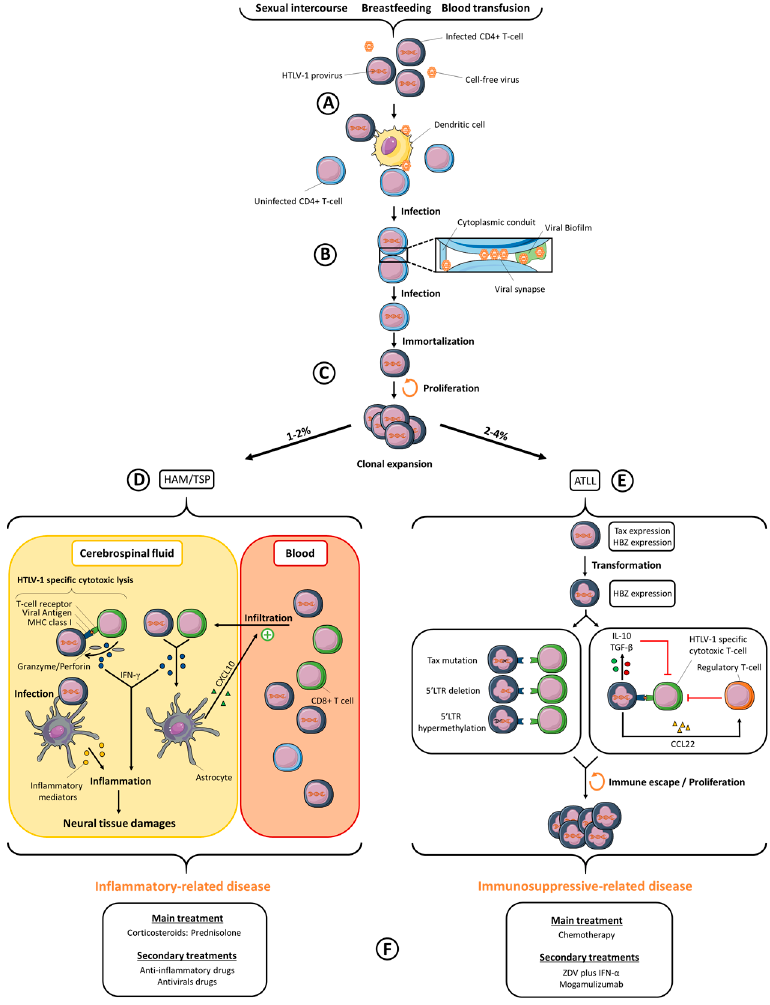
Figure 1. The course of HTLV-1 (Human T-cell Leukemia Virus type-1) infection. ( A ) HTLV-1 transmission through sexual intercourse, breastfeeding or contaminated blood products will allow the dissemination of HTLV-1 infected cells at the vicinity of dendritic cells, which are then able to transmit HTLV-1 viruses to CD4+ T-cells; ( B ) Neo-infection of CD4+ T-cells, which requires a cell-cell contact between an infected and a non-infected T-cell, is achieved through cellular conduits, the viral synapse or the viral biofilm; ( C ) Tax expression in HTLV-1 infected cells will result in consequent cell signaling alterations, such as continuous proliferation and apoptosis inhibition. Immortalized HTLV-1 infected cells will then proliferate through mitotic divisions, also known as clonal expansion; ( D ) TSP/HAM (Tropical Spastic Paraparesis/HTLV-1 Associated Myelopathy) is an inflammatory-related disease, which appears in 1 to 2% of infected individuals. The production of IFN- γ (Interferon- gamma), by HTLV-1 infected cells and HTLV-1 specific cytotoxic cells infiltrated in the cerebrospinal fluid, will lead to neural tissue damages, both directly by exacerbating inflammatory responses and indirectly by recruiting more IFN- γ producing cells in the CSF (Cerebrospinal fluid) through CXCL10 (C-X-C motif chemokine ligand 10) expression by astrocytes. ( E ) ATLL (Adult T-cell Leukemia/Lymphoma) is an immunosuppressed-related disease, which appears in 2 to 4% of infected individuals. The accumulation of genetic alterations in HTLV-1 infected T-cells leads to their transformation, and subsequent loss of Tax expression, either by mutations in the Tax gene or genetic modifications of the proviral 5 ′ LTR (Long Terminal Repeat). HTLV-1 transformed cells can escape from CTL (Cytotoxic T-cell) responses, through the loss of viral antigens presentation to the T-cell receptor, the production of Th1 (T-helper 1) inhibitory cytokines, and the recruitment of regulatory T-cells via CCL22 (C-C motif chemokine ligand 22) expression; ( F ) Current options to treat patients with TSP/HAM or ATLL.